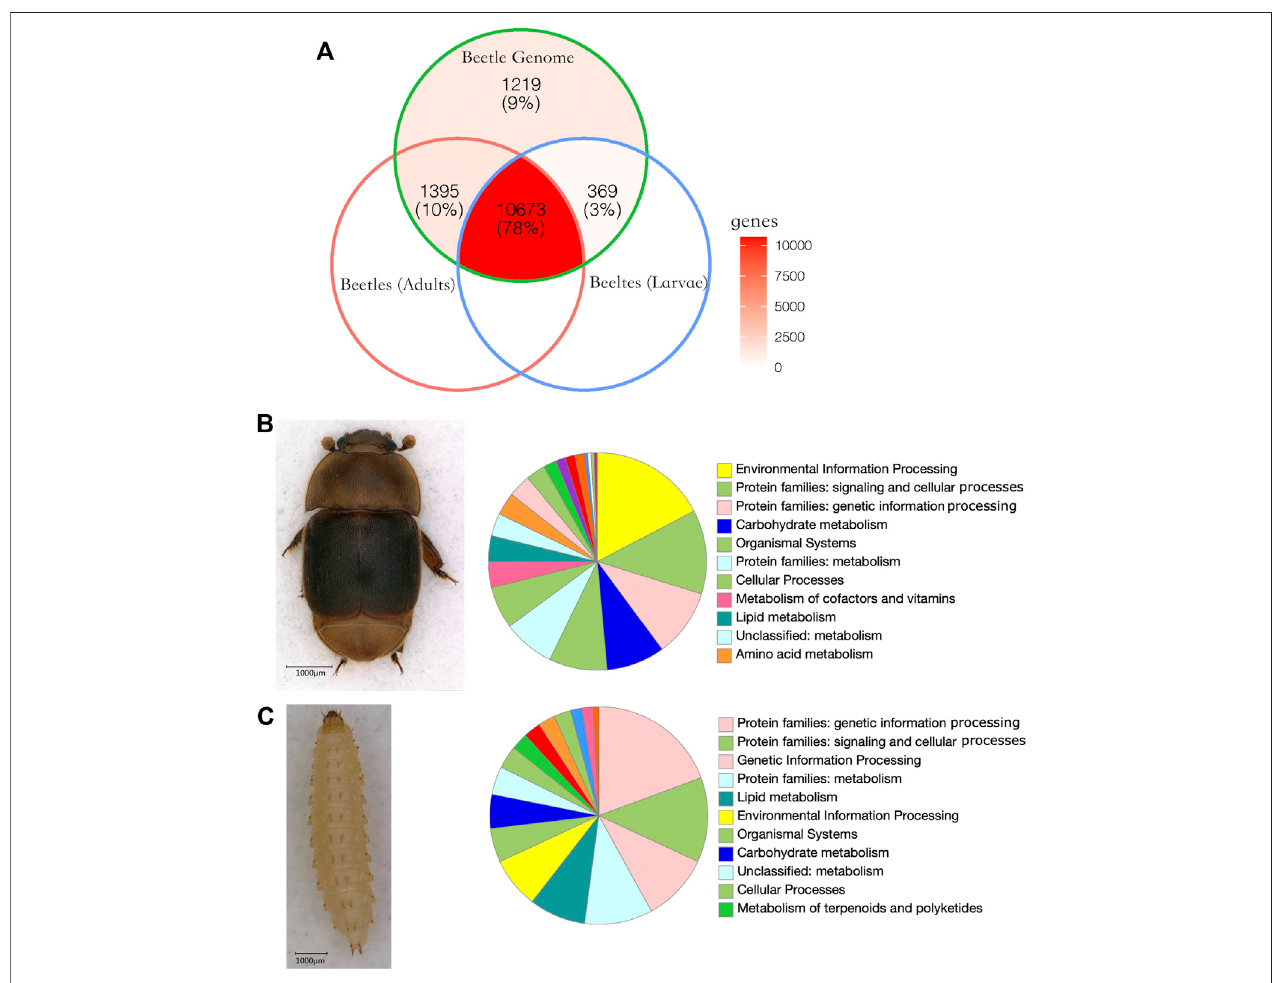
FIGURE 3 | Gene expression of small hive beetles. (A) Venn diagram of expressed genes in SHB adults and larvae. In the beetle genome, 13,656 protein-coding geneswere annotated. Overall, 78%geneswere expressed in both adults and larvae. (B) Signi fi cantly upregulated genes in adults. In total, 460 genes were signi fi cantly upregulated in adults compared with larvae SHBs, and the genes were enriched in environmental information processing. (C) Signi fi cantly upregulated genes in larvae. Overall, 203 genes were signi fi cantly upregulated in larvae compared with adults and the genes associated with translation, replication, and repair showed a high relative abundance compared with